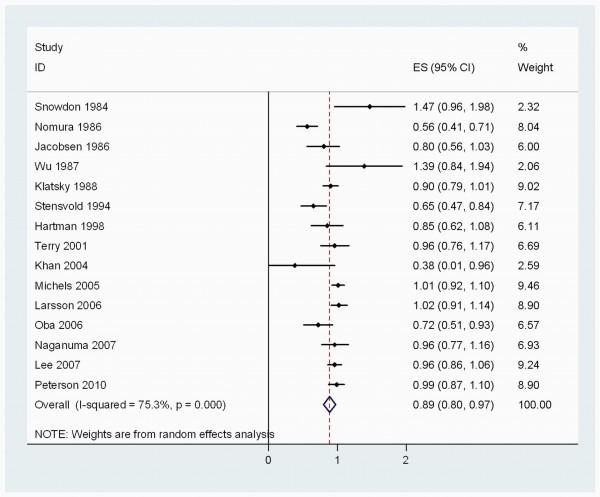
Summary RRs of colorectal cancer for high coffee drinkers versus non/lowest drinkers from included studies. Squares represent study-specific relative risk estimates (size of the square reflects the study-specific statistical weight, that is, the inverse of the variance); horizontal lines represent 95% CIs; diamonds represent summary relative risk estimates with corresponding 95% CIs.